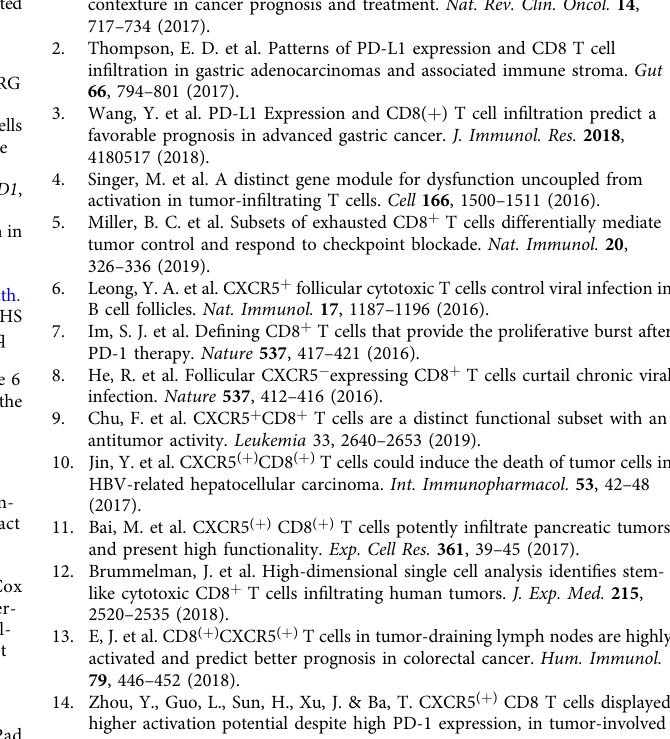
mean±SD of each with n = 10 (Ki-67) individual patients. j The transcription factors of PD-1 + CXCR5 + CD8 + T cells and PD1 + CD39 + CXCR5 − CD8 + T cells from GC tissues. Graph shows mean±SD of each with n = 10 (Eomes), n = 10 (T-bet), n = 8 (TOX), and n = 10 (TCF7) individual patients. f – j Statistical analysis by two-tailed unpaired t test. Source data are provided as a Source data fi